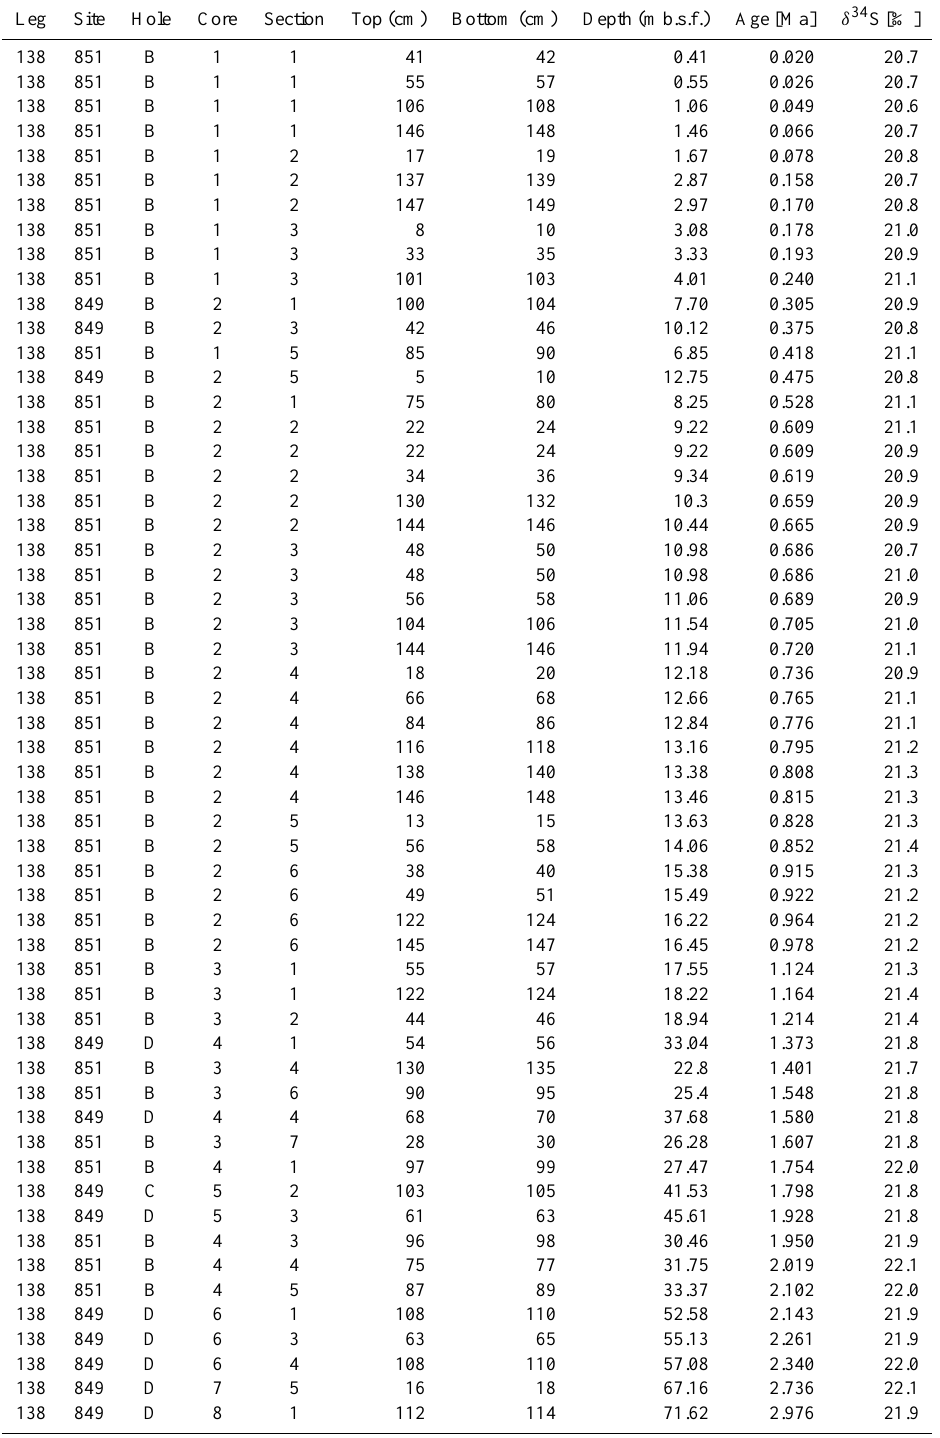
Table A1. Sample list with sulfur isotope